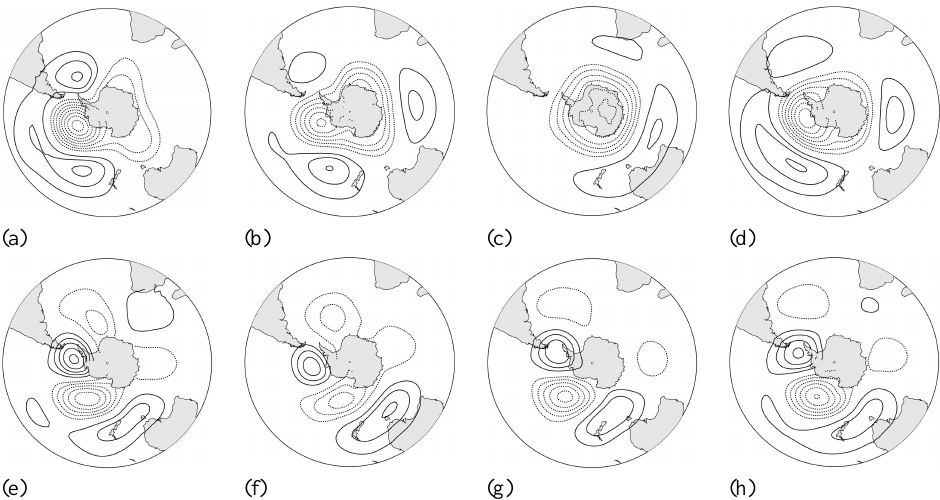
Fig. 6. (a) First EOF of 850hPa geopotential height for CMIP5, historical run, 1948-2003, HadGEM2-ES (24.0% of explained variance). (b) The same as in (a) for GFDL-ESM2M (26.2% of explained variance). (c) The same as in (a) for MPI-ESM-MR (29.6% of explained variance). (d) The same as in (a) for CCSM4 (26.6% of explained variance). (e) Second EOF of 850hPa geopotential height for CMIP5, historical run, 1948-2003, HadGEM2-ES (12.2% of explained variance). (f) The same as in (e) for GFDL-ESM2M (18.2% of explained variance). (g) The same as in (e) for MPI-ESM-MR (11.5% of explained variance). (h) The same as in (e) for CCSM4 (15.9% of explained